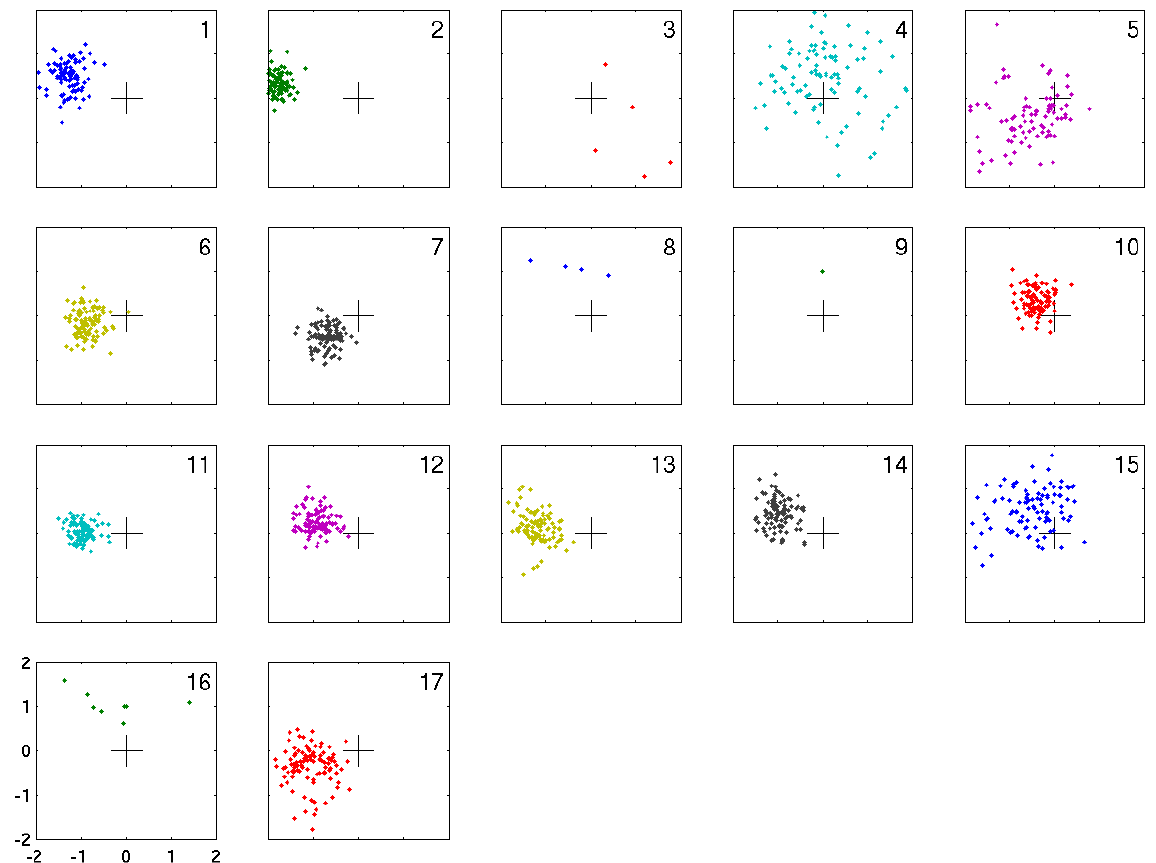
Figure 5. Scatter of p ANN m for each site with noise added to the bottom-pressure records. Subplot axes are identical to Fig.